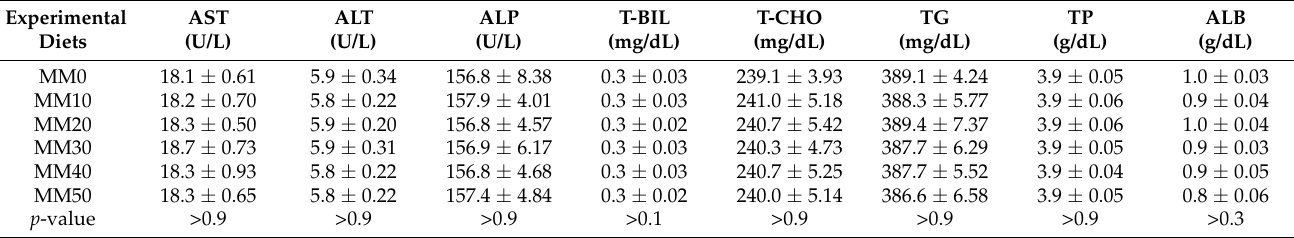
Table 6. Hematological parameters of olive flounder fed the experimental diets for 56 days.